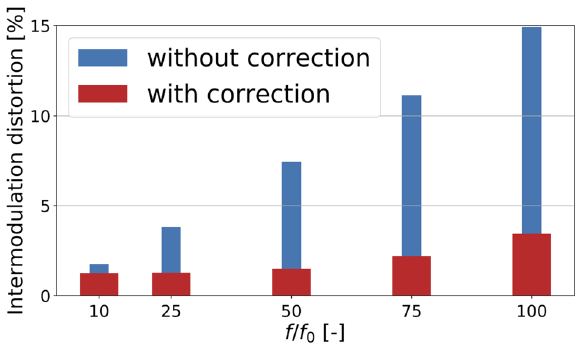
Figure 14. Evolution of the intermodulation distortion IMD P ð f Þ with f = f 0 . The intermodulation distortion due to Doppler effect (in blue) reaches 15% at f = f 0 ¼ 100. The correction algorithm D H (in red) maintains the distortion level below